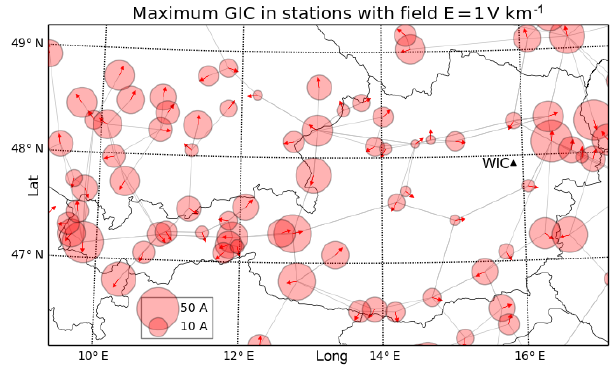
Figure 7. Maximum GICs at the various stations in the Austrian and nearby network for all orientations of a geoelectric field with magnitude 1Vkm − 1 . Each circle represents a node, and the line connections between nodes are shown in grey. The size of the circle represents the magnitude of GICs, while the arrows depict the geo- electric field orientation that leads to a maximum at that node. The position of the Conrad Observatory (WIC) is marked by the black